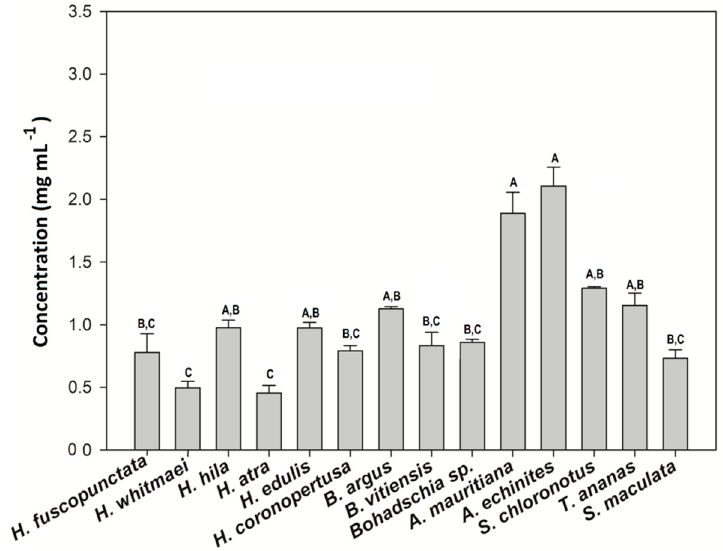
Figure 6. Saponin concentration of the 14 tested sea cucumber crude extracts. Results express average values + standard error. ( A – C ) indicate significant differences between sea cucumber crude extracts. The Kruskal-Wallis post-hoc method for multiple comparisons was applied ( p < 0.05 ).